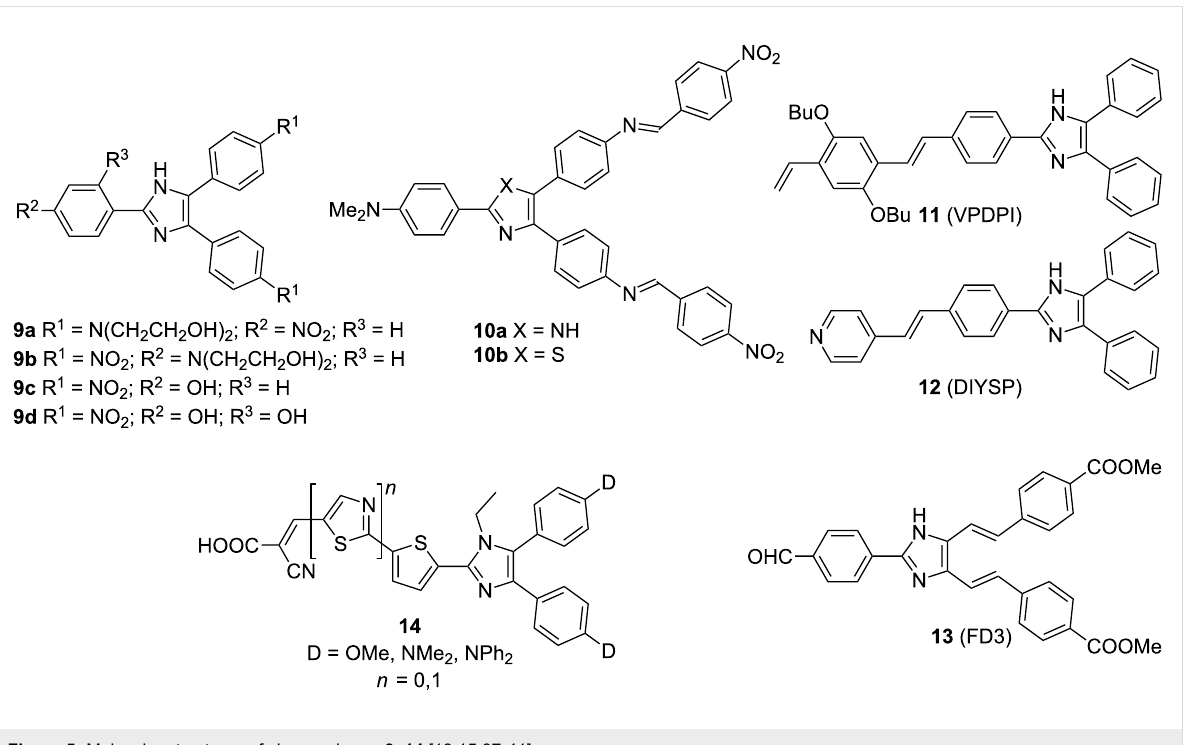
spacers at the imidazole C4/C5 and nitro and dimethylamino groups as acceptor and donor [15], chromophore 11 (VPDPI) represents a polarizable blue-light-emitting material [37]. The newly synthesized chromophores were investigated in terms of their absorption and emission properties, molecular first-order hyperpolarizability β , measured by solvatochromic method at 1907 nm, and thermal stability determined by TGA or DTA (Figure 5, Table 3). Imidazoles 12 (DIYSP, δ = 41